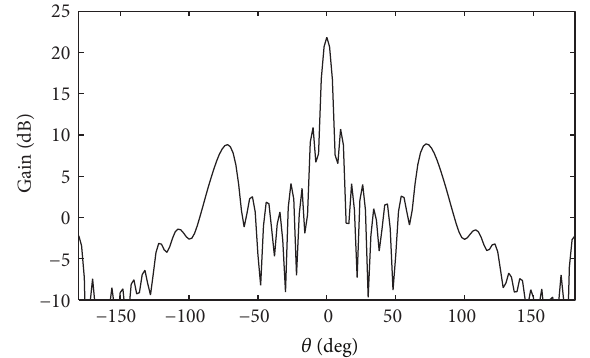
Figure 6: Simulated gain in 𝑦𝑧 plane at 5.85 GHz.